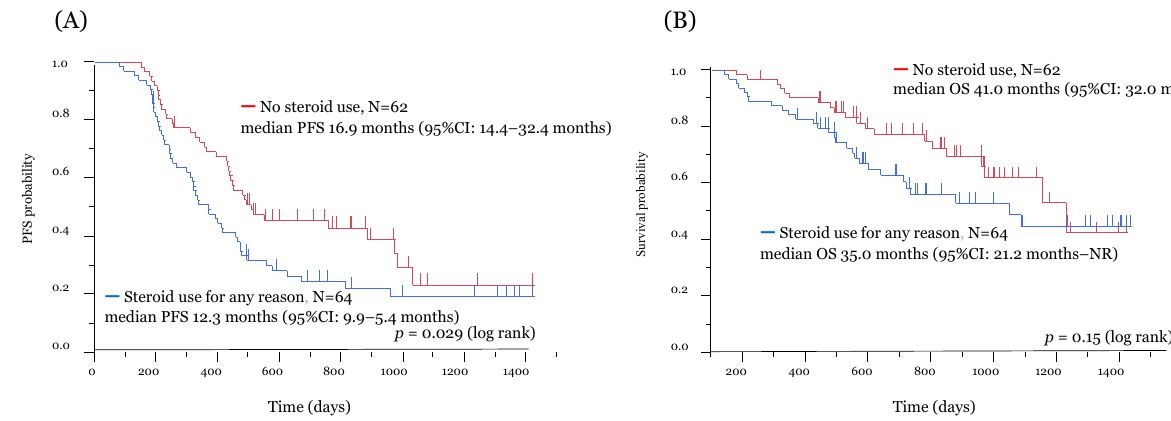
Figure 3. Kaplan–Meier survival analysis according to systemic steroid use for any reason. The figures show Kaplan–Meier curves for PFS ( A ) and OS ( B ) in the systemic steroid use for any reason cohort (blue line) and the no steroid use cohort (red line). Survival analysis with ICI treatment: significant difference in PFS and no significant difference in OS. irAE, immune-related adverse event; PFS, progression-free survival; OS, overall survival; NR, not reached.